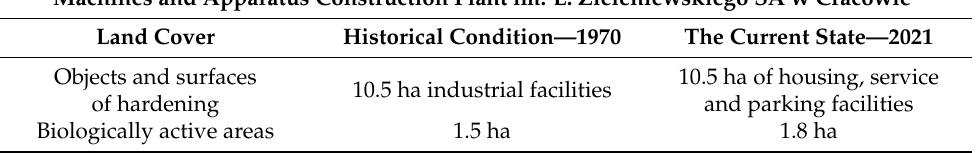
Table 2. Comparision of the change in the function of the industrial area in Cracow as a potential hydrological window on the example of one of the factories in Cracow. Restructuring completed in 2021. Machines and Apparatus Construction Plant im. L. Zieleniewskiego SA w